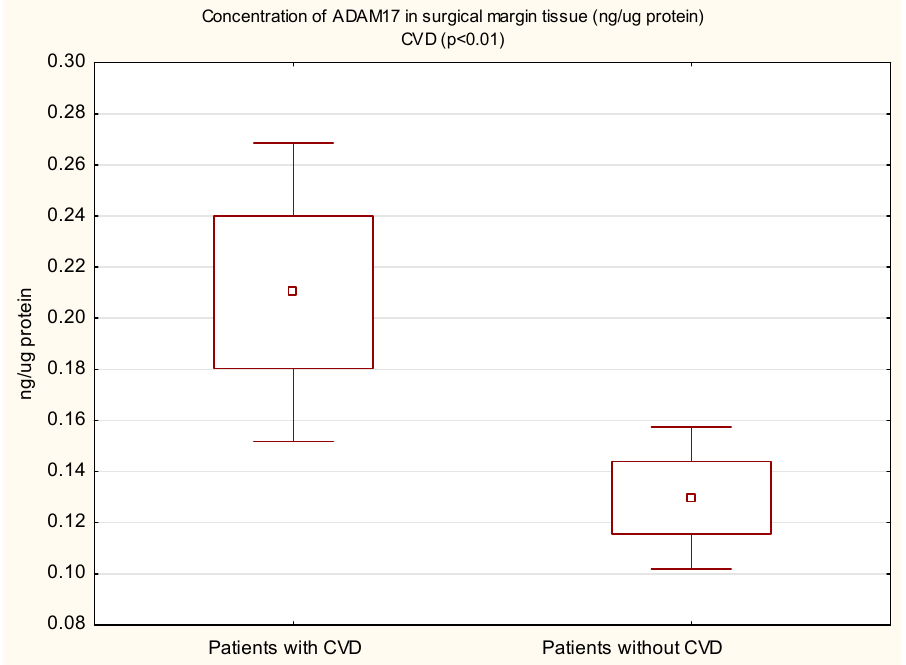
Figure 4. Concentration of ADAM17 protein in tumor tissue in CRC patients with and without co- existing CVD.